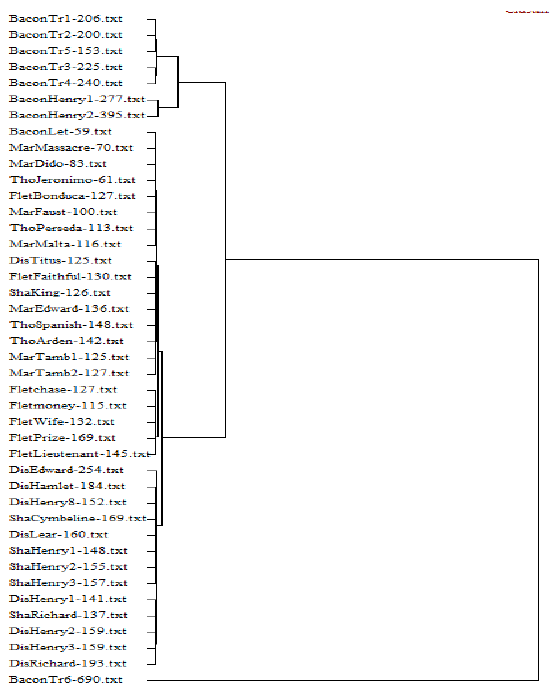
Figure 2. A linear hierarchical cluster analysis of a 42 × 60 D FW using Squared Euclidean distance and an increase in sum of squares prior to text length normalization.